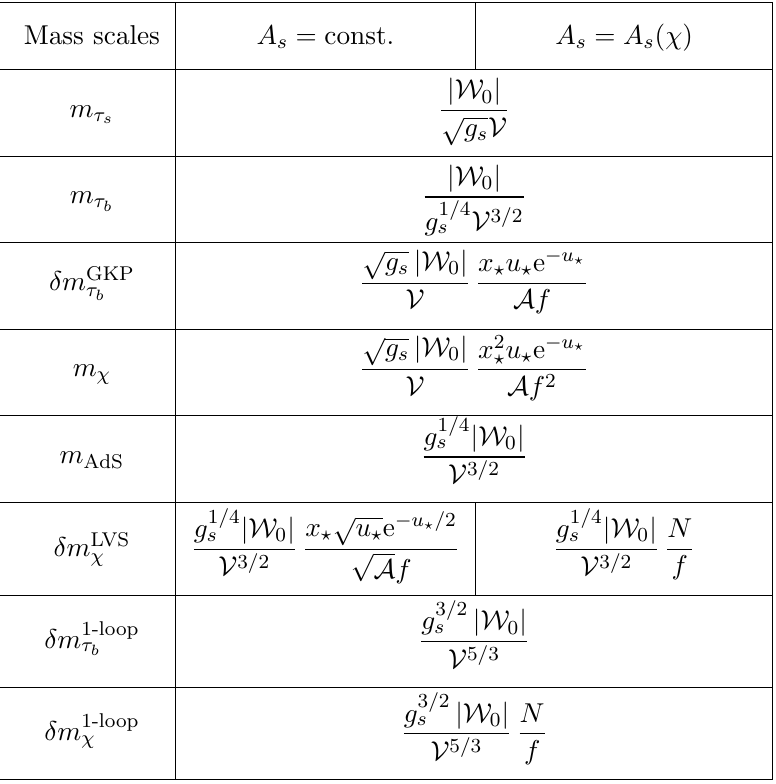
Table 1 . The table summarises the appearing mass scales and the magnitude of the di(cid:11)erent corrections. We divided all results by a factor of e K cs = 2